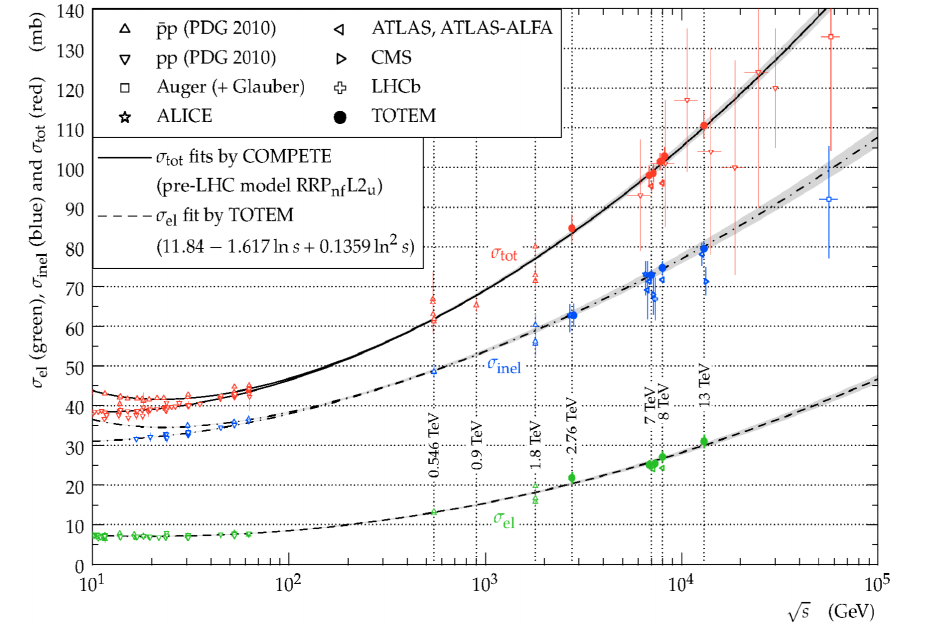
Figure 1. The energy dependence of the total, elastic and inelastic proton-proton cross